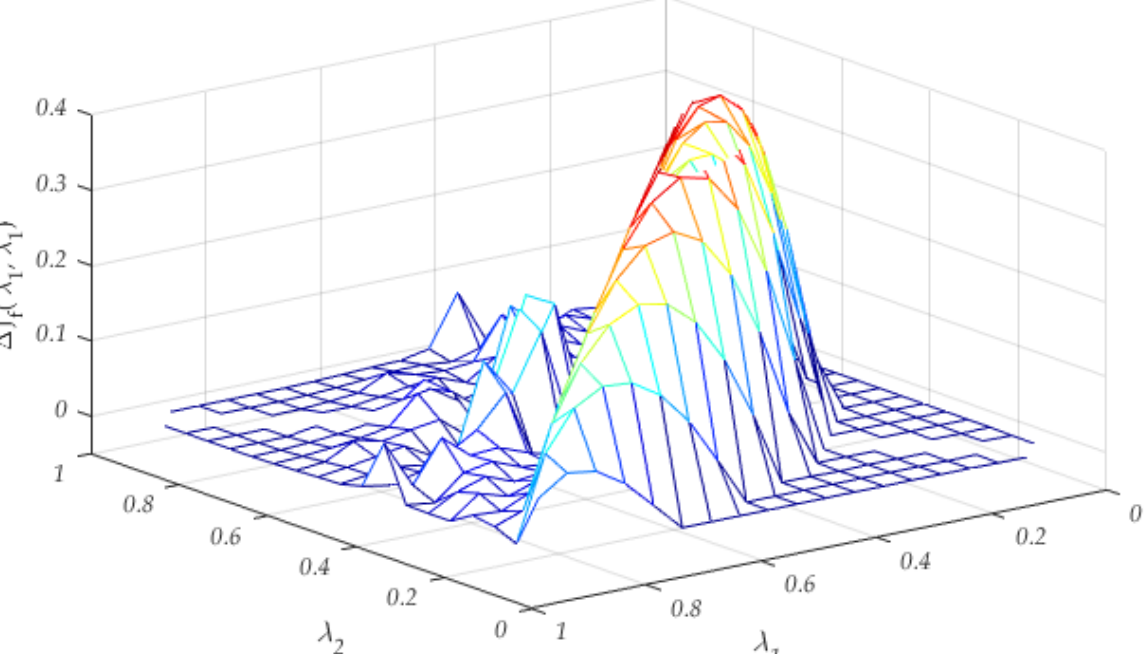
Figure 5. Function Surface (34), which depicts additional error caused by using of fractional lag